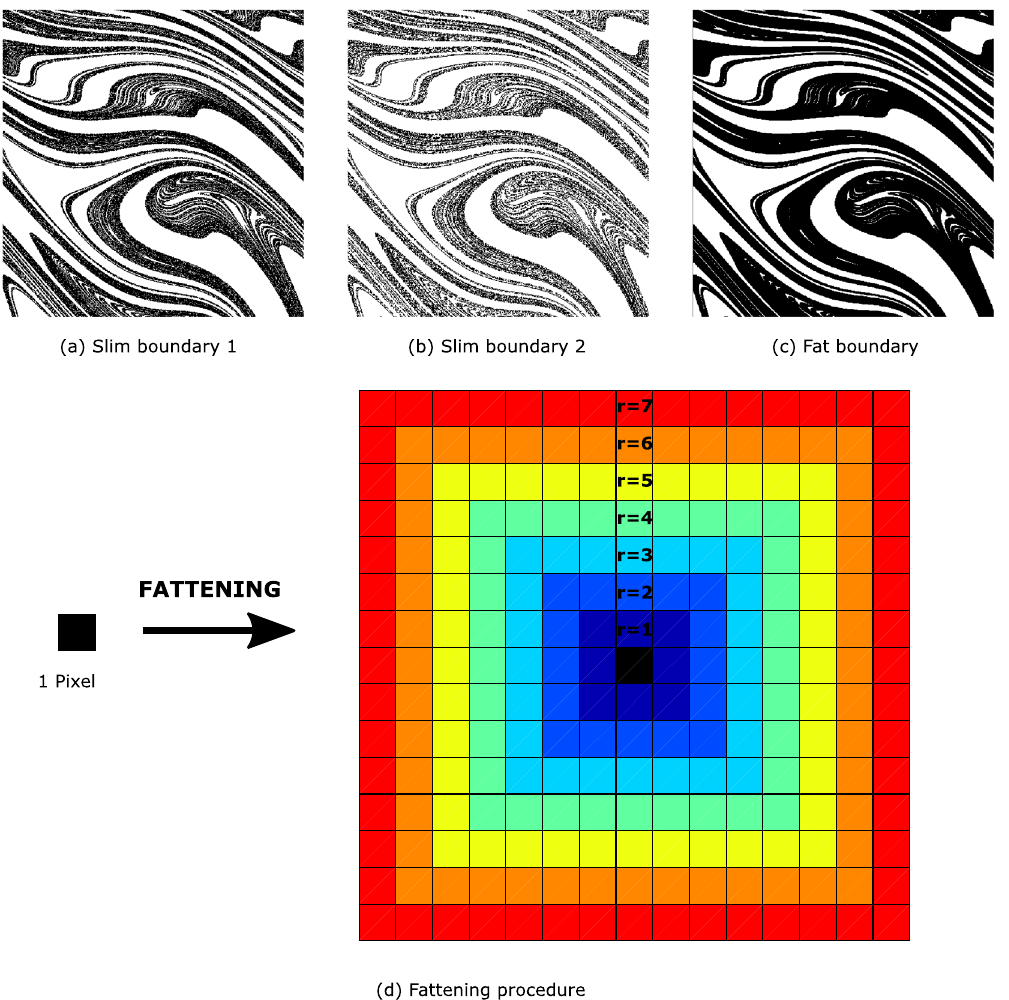
Figure 2. The fattening procedure. ( a,b ) Even for Wada basins, the boundaries are not exactly the same for all the merged basins because of the finite resolution. ( c ) To avoid this effect, the boundaries must be fattened. ( d ) In the fattening procedure, each pixel in the boundary is substituted by a fat pixel of radius r . In the plot, each color corresponds to a different radius in the Chebyshev or chessboard distance. We call r the fattening parameter